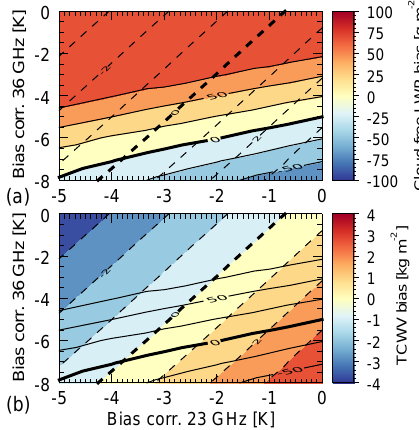
Figure 2. The coloured contour plot in (a) shows contours of LWP bias as function of bias correction values for 23GHz ( x axis) and 36GHz ( y axis). The coloured contour plot in (b) shows biases in TCWV. In addition, labelled isolines of both TCWV bias (dashed) and LWP bias (solid) are overlaid in both plots. Data are shown for ERS-1, June